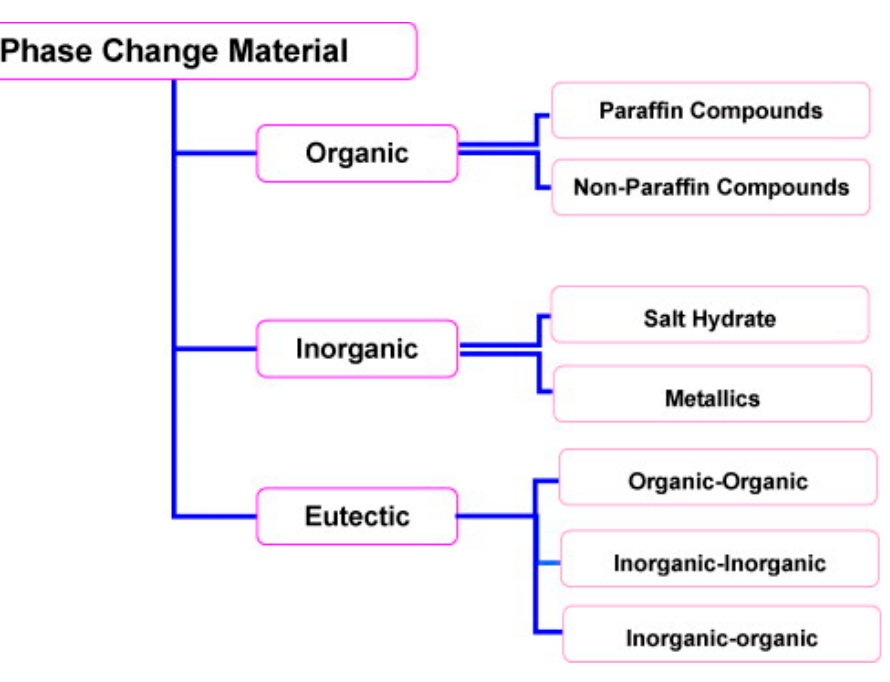
Figure 2 . Major categories of PCM (Copyright 2007 Elsevier) [9] . Figure 2. Major categories of PCM (Copyright 2007 Elsevier)